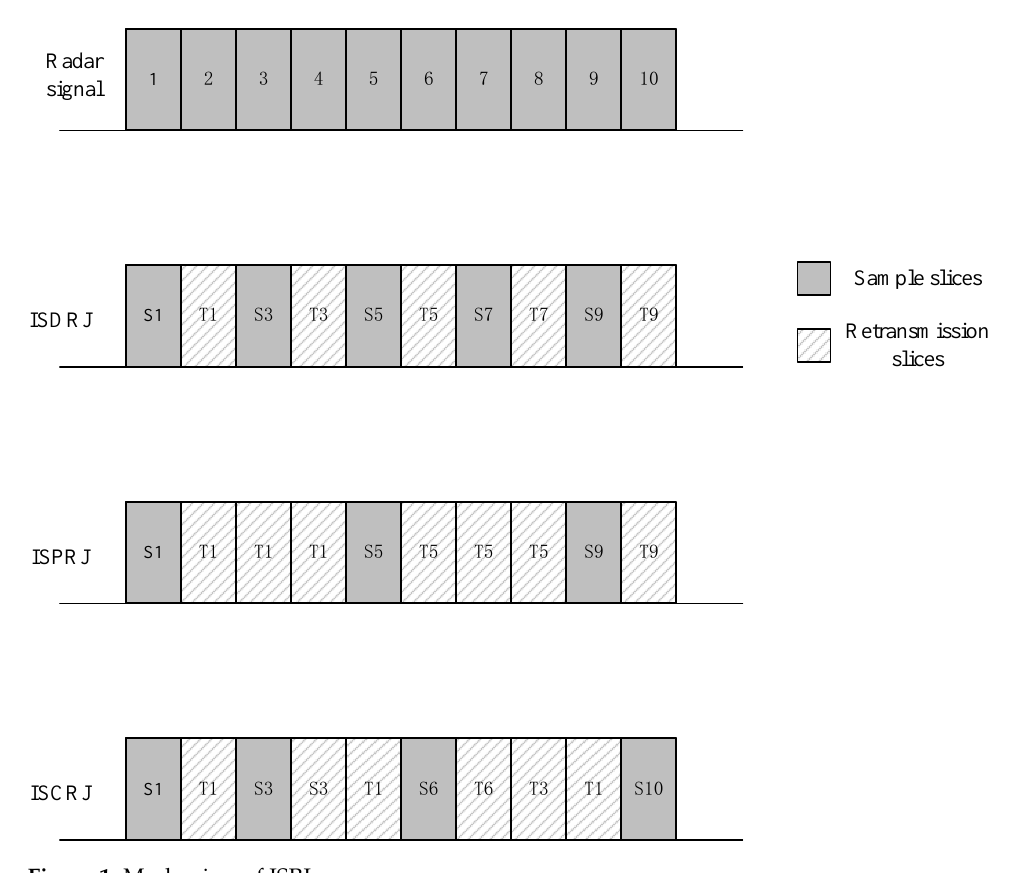
Figure 1. Mechanism of